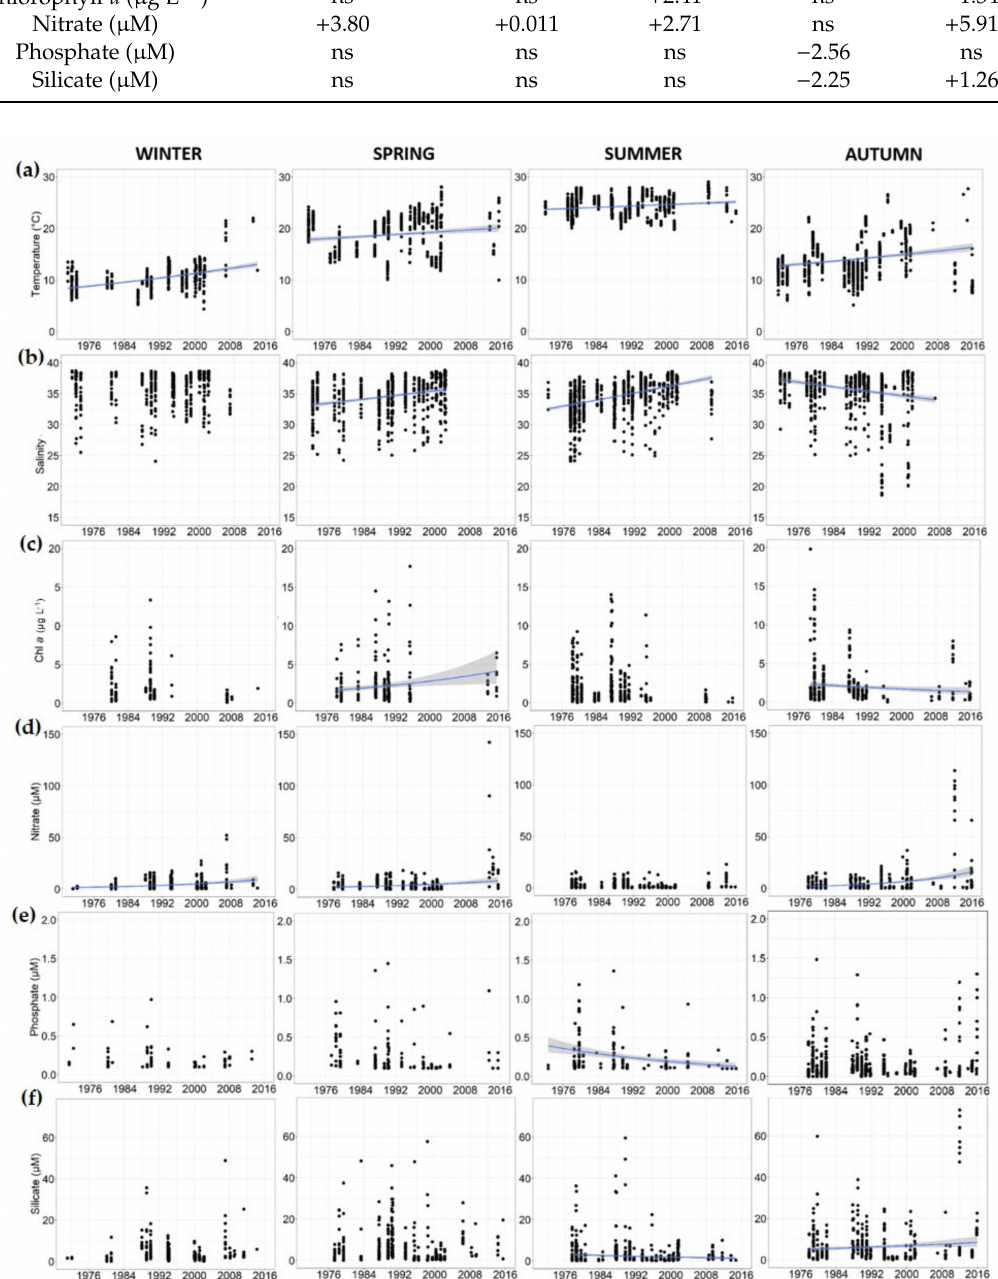
Figure 4. Seasonal surface trends of ( a ) temperature ( ◦ C), ( b ) salinity, ( c ) chlorophyll-a ( µ g L − 1 ), ( d ) nitrate ( µ M), ( e ) phosphate ( µ M) and ( f ) silicate ( µ M) from 1971 to 2015. The blue line represents the long-term trend with the 95% confidence limits (gray range). When the slope was not significant ( p -value > 0.05), the long-trend line was not